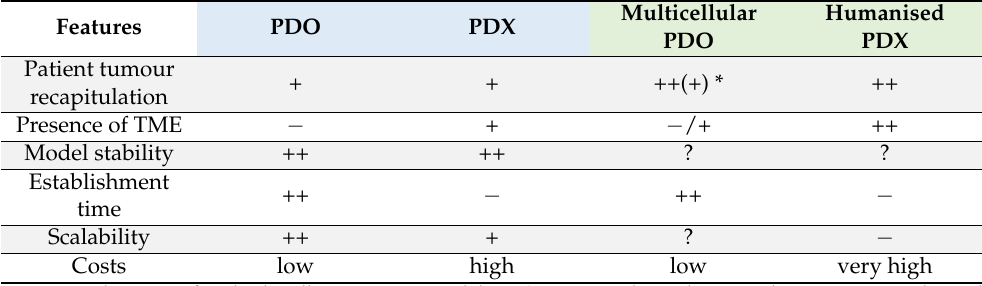
Table 1. Overview of the features of the various patient-derived models.